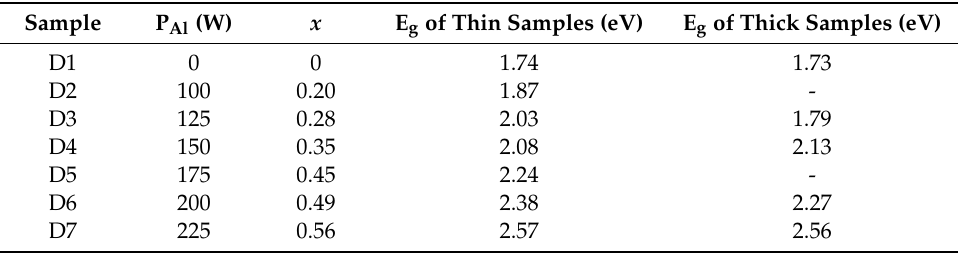
Table 1. Summary of the optical bandgap energy (E g ) of the Al x In 1 − x N on Si devices.